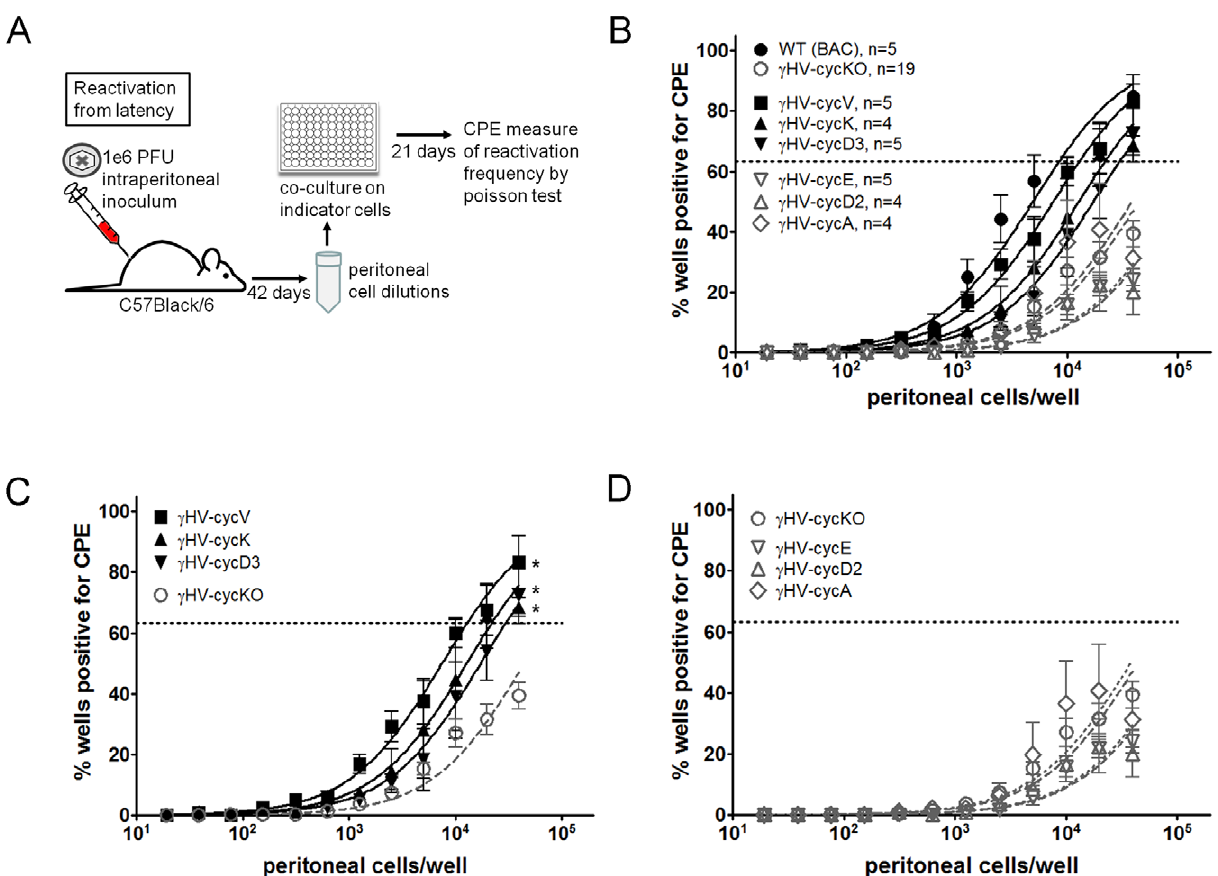
Figure 4. Viral cyclins and cyclin D3 compensate in reactivation from latency. (A) Schematic representation of infections and determination of ex vivo reactivation in C57BL/6 mice. (B–D) Limiting-dilution ex vivo reactivation from latency of PECs from mice infected with (B) compiled WT, gHV-cycKO and recombinant cyclin viruses, (C) gHV-cycV, gHV-cycK and gHV-cycD3 viruses that complement in reactivation and (D) gHV-cycA, gHV- cycE and gHV-cycD2 viruses that do not complement in reactivation. Data represent the mean 6 SEM of the indicated number of independent experiments, with each experiment containing cells pooled from three to five mice and each experiment including the gHV-cycKO virus. The dashed line is at 63%, the value which was used to calculate the frequency of reactivating cells as indicated by a Poisson distribution. Reactivation frequencies were as follows: WT-gHV 1/8729, gHV-cycV 1/13152, gHV-cycK 1/19952, gHV-cycD3 1/25118; and less than 1/80000 for gHV-cycKO, gHV- cyc, gHV-cycE and gHV-cycA. Frequencies of reactivation were significantly increased by gHV-cycV (*p=0.01), gHV-cycK (*p=0.02) and gHV-cycD3 (*p=0.03) compared to gHV-cycKO, as determined by paired t-test.